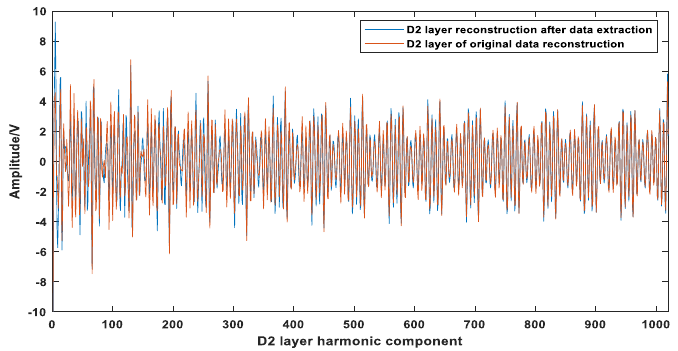
Figure 12. D2 layer reconstruction attenuation component. Figure-12. D2 layer reconstruction attenuation component.